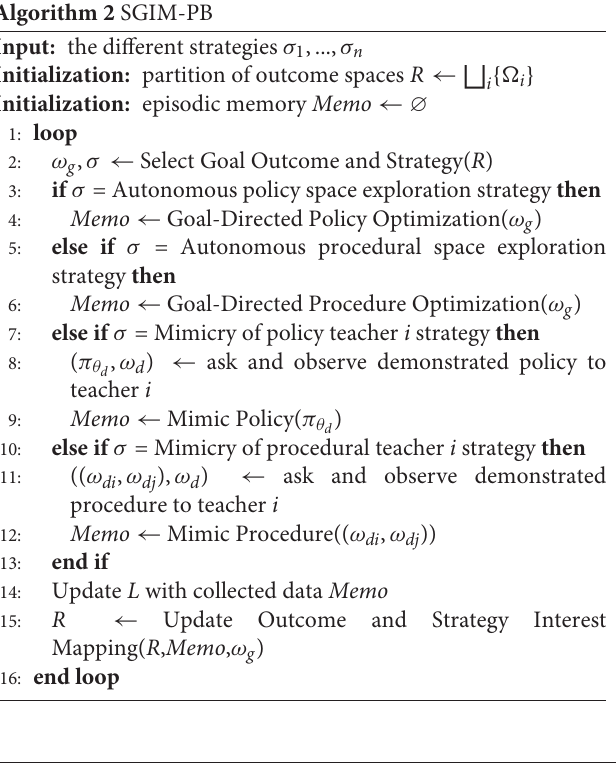
Algorithm 2 SGIM-PB